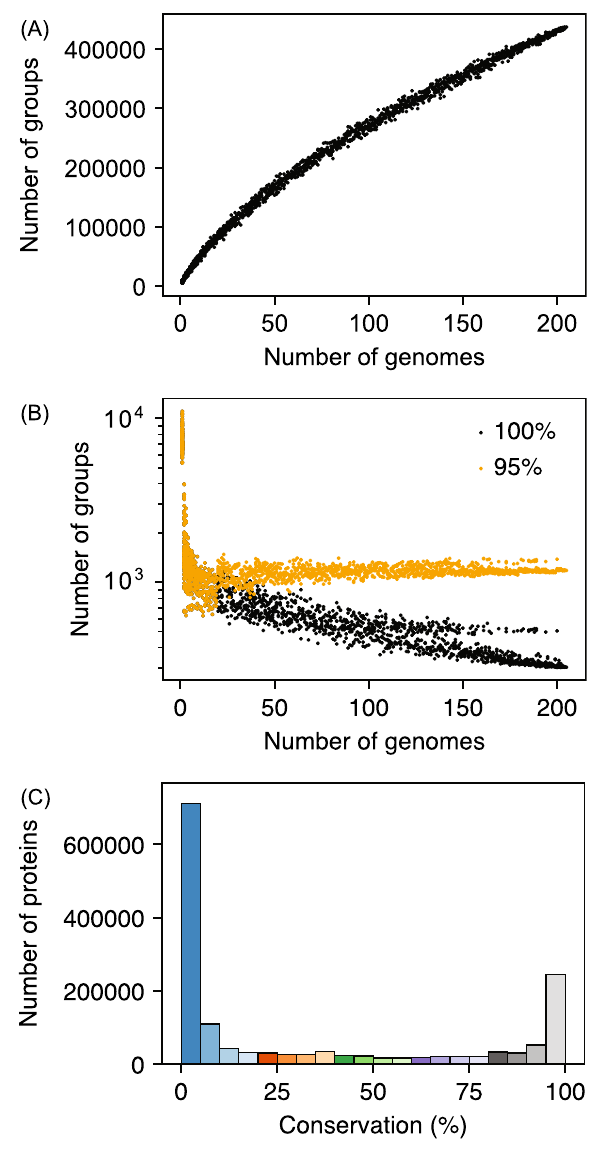
Figure 2. ( A ) Change in the pangenome size as a function of the number of genomes. X axis is the number of genomes used to construct the pangenome and Y axis is the number of orthologous groups identified in the same pangenome. ( B ) Change in the number of orthologous groups conserved in all the genomes and at least 95% genomes with the varying number of genomes. ( C ) The total number of proteins in each conservation bin from the Streptomyces pangenome. The bar colours correspond to the scheme indicated in Fig.